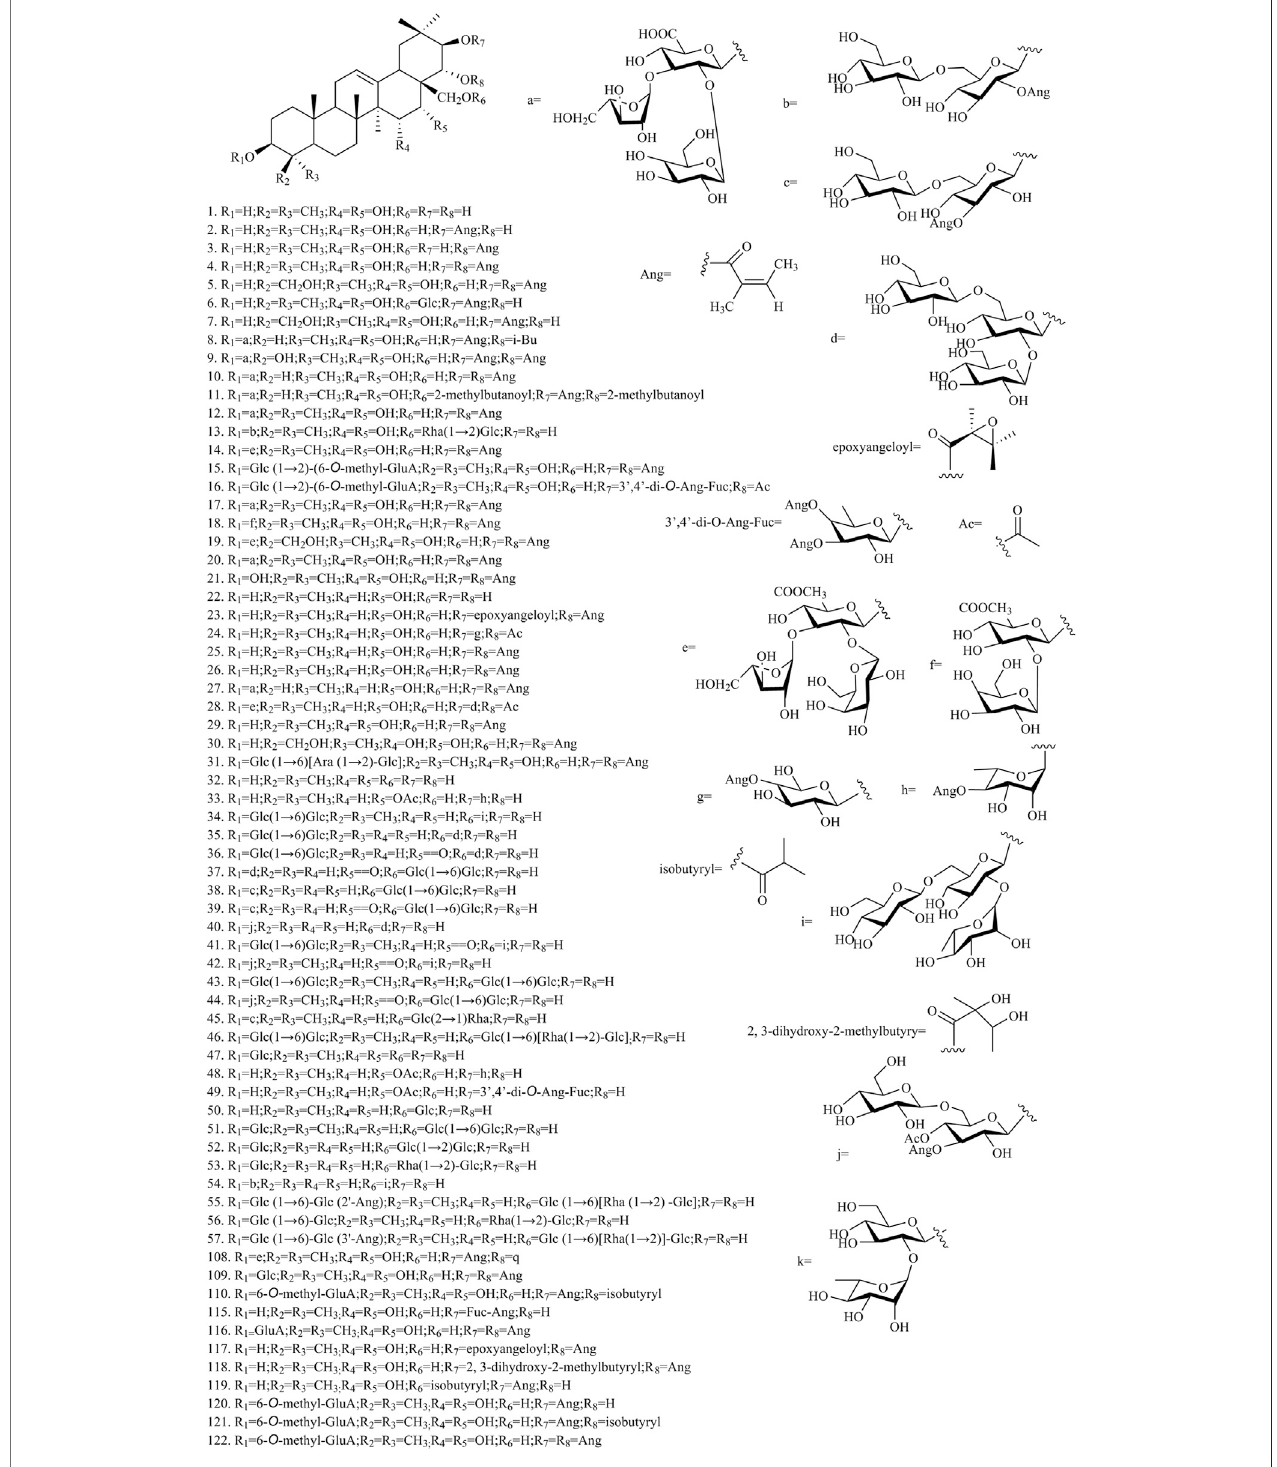
FIGURE 2 | Structures of triterpenoids in X. sorbifolium. chromatography (TLC), 1 H-NMR, 13 C-NMR, and MS (Wu, 2017). The chemical structures of fl avonoids are provided in Figure 3 .